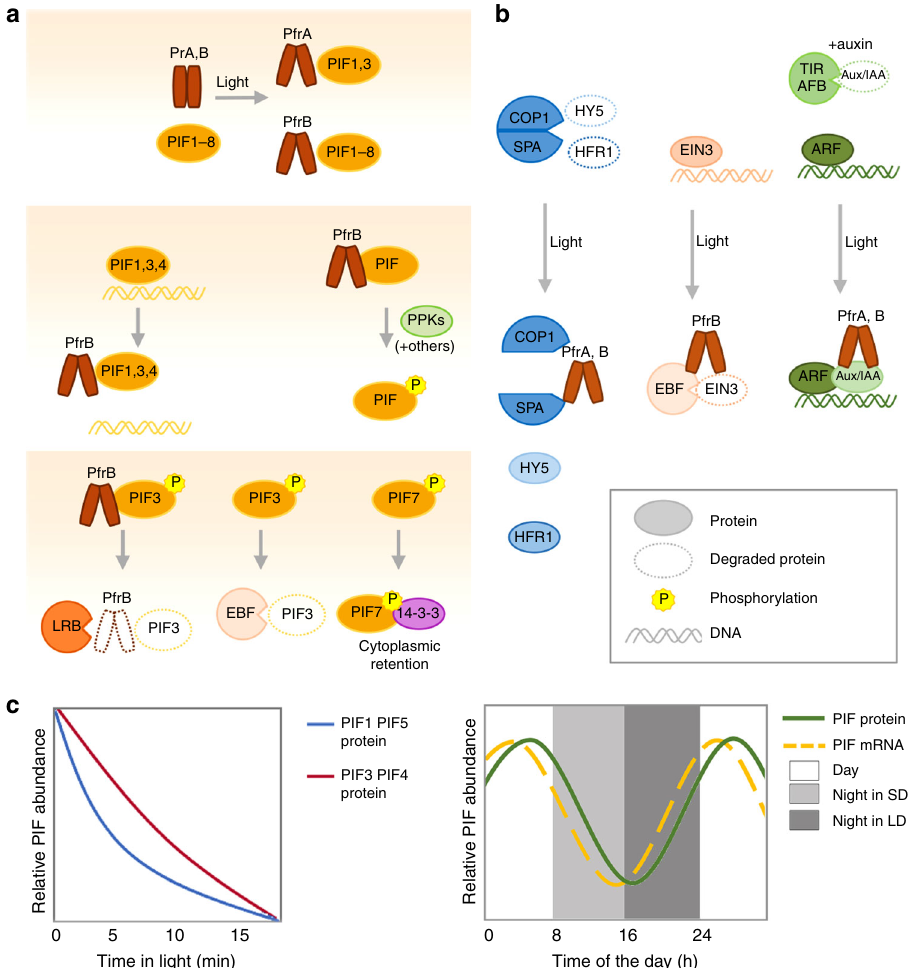
Fig. 4 Mechanisms of phytochrome-mediated regulation of transcription factors. a From top to bottom, sequential steps by which Pfr inhibits PIFs. Top: PfrA interacts with PIF1 and PIF3 while PfrB interacts with PIF1 – PIF8. Middle left: for PIF1, 3 and 4 phytochrome inhibits DNA binding. Middle right: Interaction with Pfr leads to phosphorylation of PIFs. Many kinases have been found to phosphorylate PIFs (see text) with PPKs phosphorylating PIFs in response to light. Bottom: after light-induced phosphorylation, PIF3 is degraded by LRBs and EBFs with phyB co-degradation occurring in the LRB-mediated process (left, center), phosphorylated PIF7 interacts with 14-3-3 proteins and remains in the cytoplasm (right). b Other mechanisms of transcriptional control by phytochromes. Left: PfrA and PfrB interact with SPA and inhibit the COP1/SPA complex. Center: PfrB interacts with EIN3 to promote ERF- mediated EIN3 degradation. Right: PfrA and PfrB interact with Aux/IAA to prevent their degradation by SCF TIR1/AFB . c Patterns of PIF abundance depending on the developmental state and growth conditions. In etiolated seedlings PIFs accumulate to high levels, promoting etiolated growth. Upon light exposure, PIFs are rapidly degraded in a phytochrome-dependent manner, with half-lives of ~5 min for PIF1 and PIF5, and ~10 min for PIF3 and PIF4 (left). In contrast, in light-grown seedlings PIFs are under strong transcriptional control, allowing accumulation of the protein even in conditions when phytochrome activity is predicted to be high (right), SD (short days), LD (long proteins 97 . Light-independent interaction between DELLAs and PIF1, PIF3, PIF4, and PIF5 leads to proteasome-mediated PIF degradation independently of phyB and LRBs 98 . Upon interaction with DELLAs PIF3 and PIF4 are also prevented from binding to DNA 99,100 . These mechanisms contribute to an important and and developmental responses 17,41,60,65 .